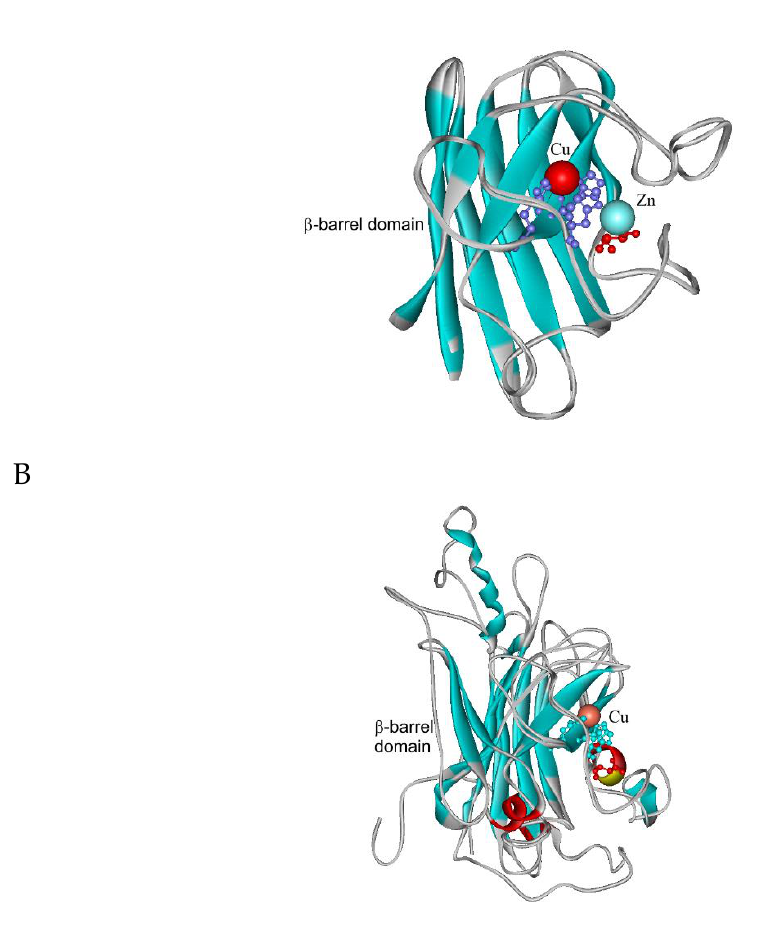
Figure 3. Structural models of two paralogous CuZnSODs from Chaetomium thermophilum var. dissitum modelled with Phyre-2 server [16]. ( A ) CthedisCuZnSOD1 modelled on the structure of 1f1g coding for ScCuZnSOD1 (from Saccharomyces cerevisiae ). ( B ) CthedisCuZnSOD2 modelled on the structure of 4n3u coding for CalbCuSOD2 (from Candida albicans ).